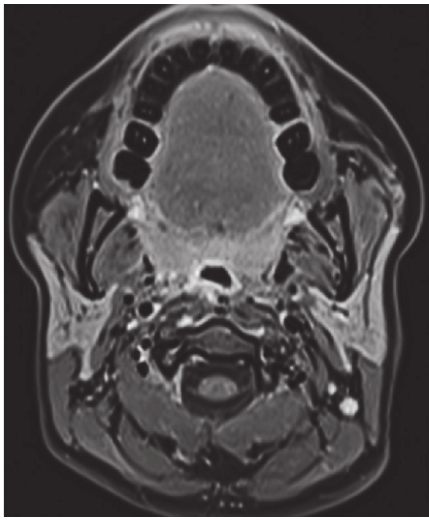
Figure 5: Postoperative (18-months) magnetic resonance imaging axial T1 postcontrast with fat suppression showing complete ex- cision of right parapharyngeal cyst with no evidence of